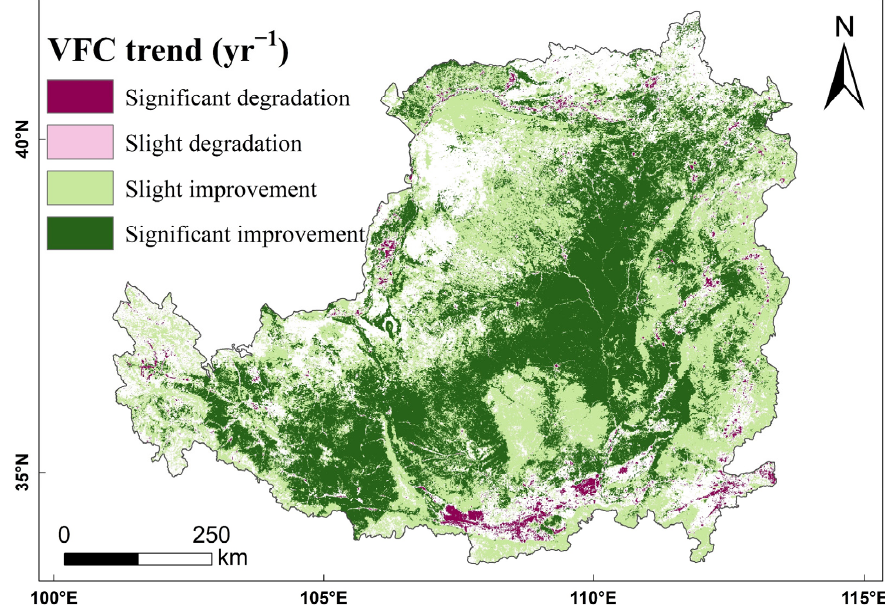
Figure 6. Spatial pattern of NDVI trends in the Loess Plateau from 2000 to 2018.